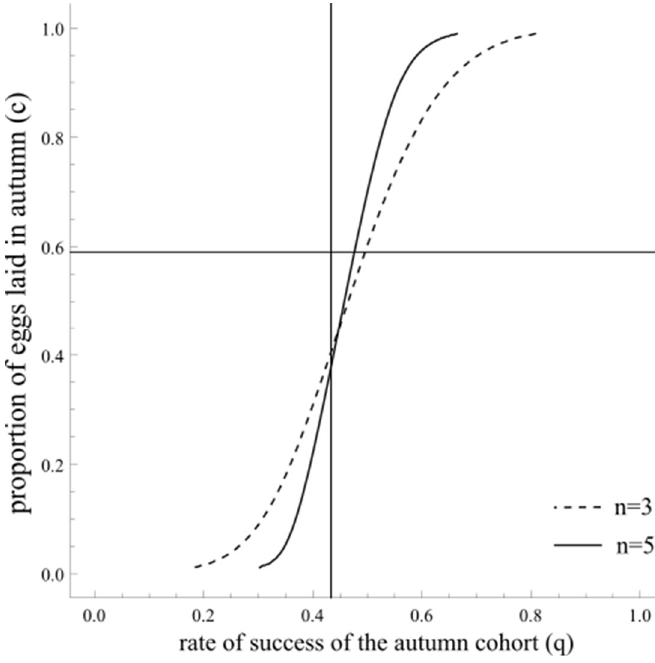
Figure 5: Evolutionary stable strategy (black lines), based on a bet-hedging model, predicting the proportion of eggs laid in autumn ( c , x-axis) in relation to the rate of success of the autumn cohort ( q , y- axis), depending on the number of breeding years (n). We set the survival rate of autumn tadpoles to 4.7% (estimated among breeding events producing offspring that survived until spring) and the survival rate of spring tapdoles to 3.8%, (estimated in absence of autumn cohort). The horizontal and vertical lines indicate the field estimates of c and q